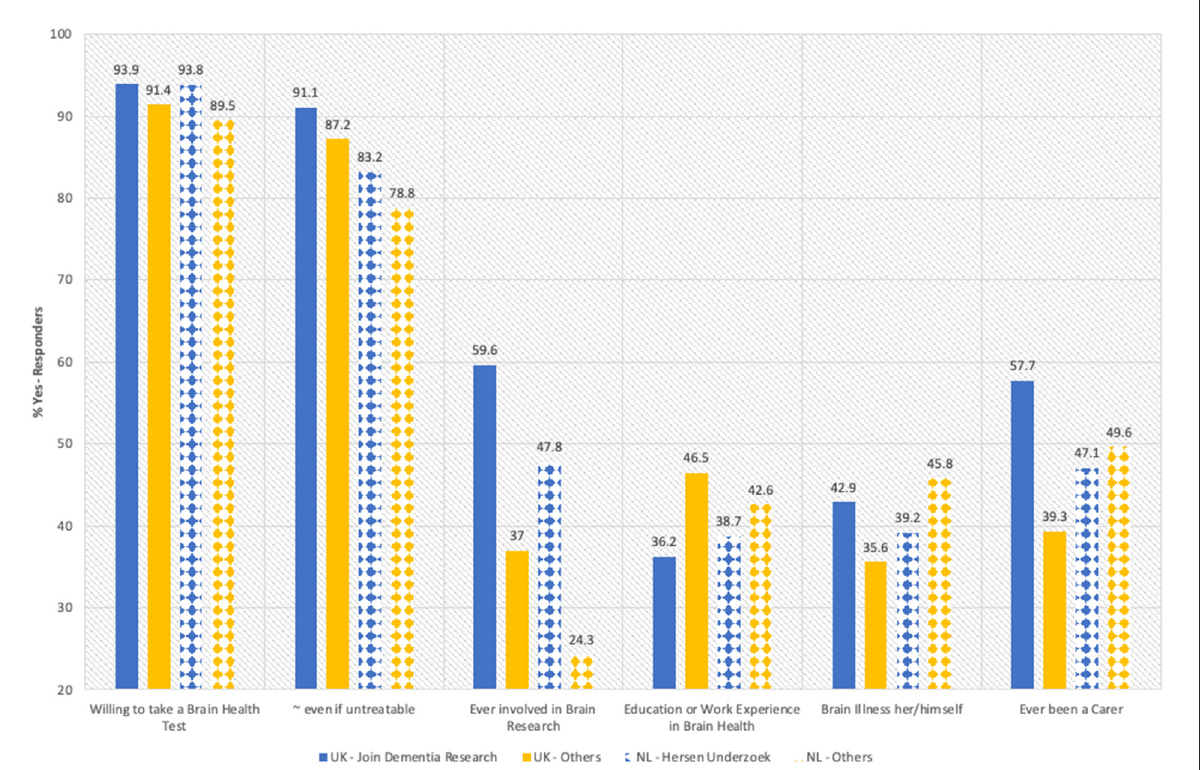
FIGURE1 Comparison between participants from research registries and the remainder from same country. The graph shows how the participants recruited from research registries Join Dementia Research and Hersenonderzoek answered relevant questions compared with other respondents from the same country (UK and NL